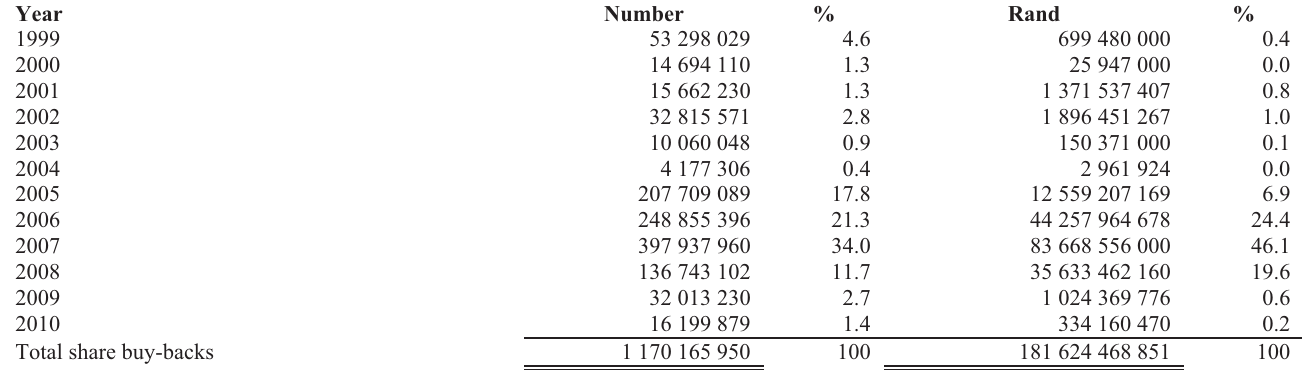
Table 7: Share buy back activities – All